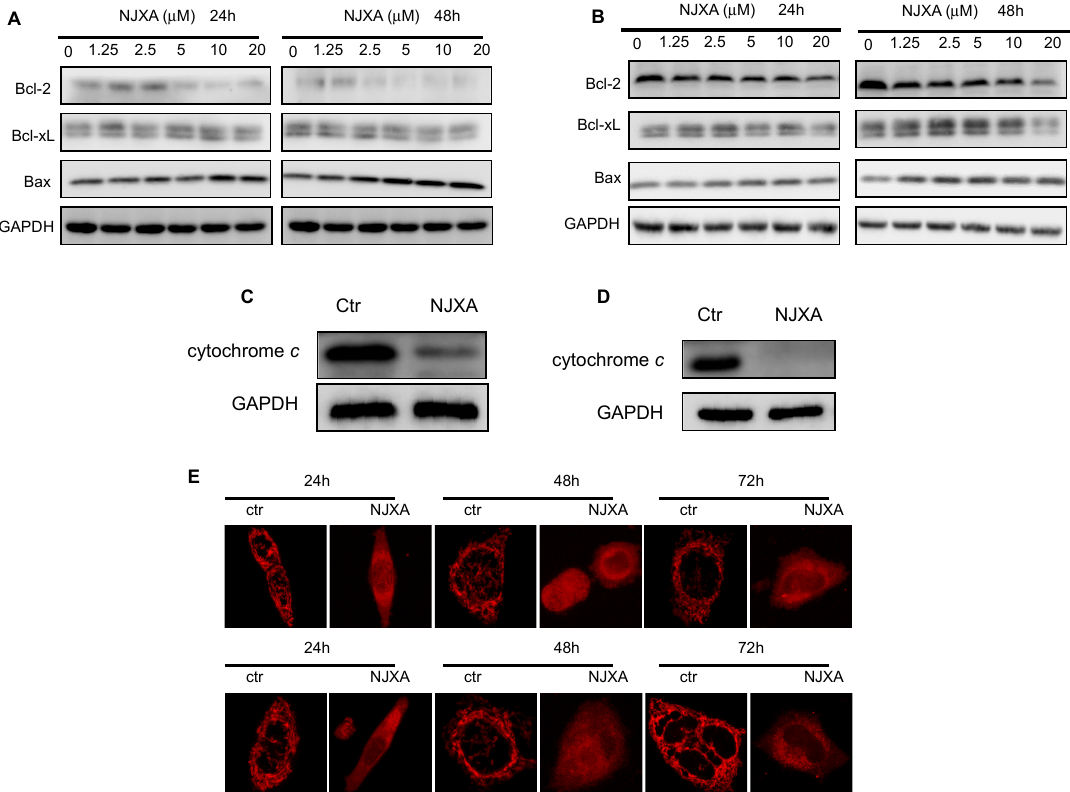
Figure 3. NJXA induces mitochondria-dependent apoptosis in HeLa and SiHa cells. ( A ) HeLa or ( B ) SiHa cells were treated with NJXA (0~20 µ M) for 24 h or 48 h, and then Bcl-2, Bcl-xL, and Bax levels were analyzed by Western blotting; ( C ) NJXA induced cytochrome c release in HeLa and ( D ) SiHa cells. The mitochondrial and cytosolic fractions of cells treated with NJXA (20 µ M) for 72 h were analyzed by Western blotting for cytochrome c and GAPDH; ( E ) MitoTracker Red staining showed that NJXA induced mitochondrial fission and swelling in HeLa ( upper panel ) and SiHa ( lower panel ) cells.